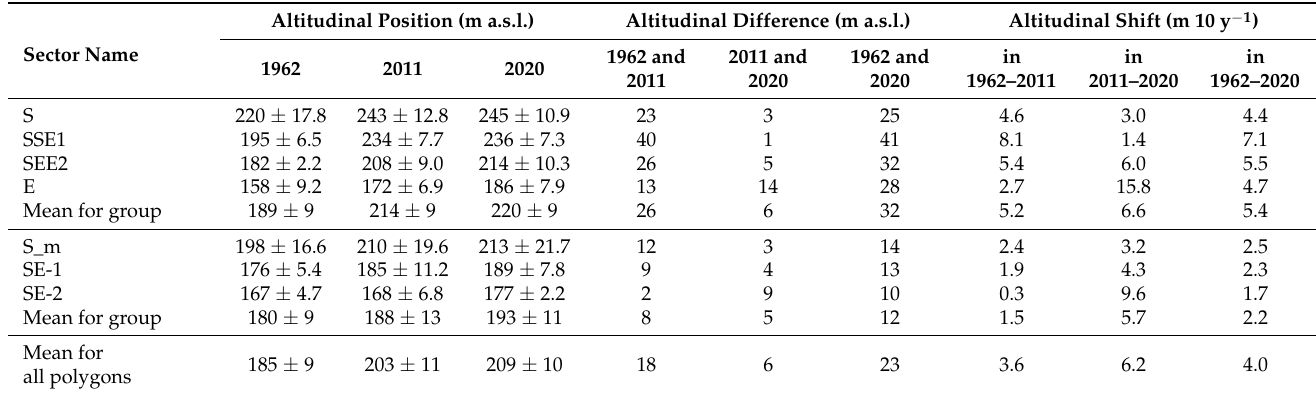
Table 3. Altitudinal position of open forest boundaries (mean ± SD) on the southern and eastern slopes of a hill with height mark of 312 m a.s.l., close to Mt. Chernaya (Polar Urals), in 1962, 2011 2020, and their vertical shift from 1962 to 2020.